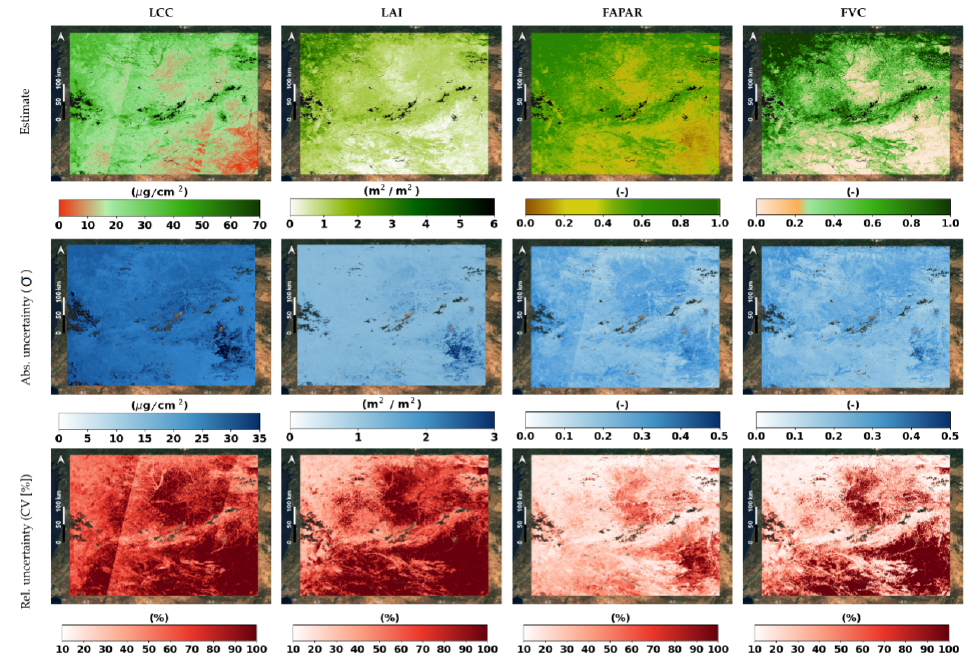
Figure 5. Retrieved daily maps, associated absolute uncertainty ( σ ) and relative uncertainty (CV) on 20 June 2019 over Iberian Peninsula (subset zoom-in indicated in Figure